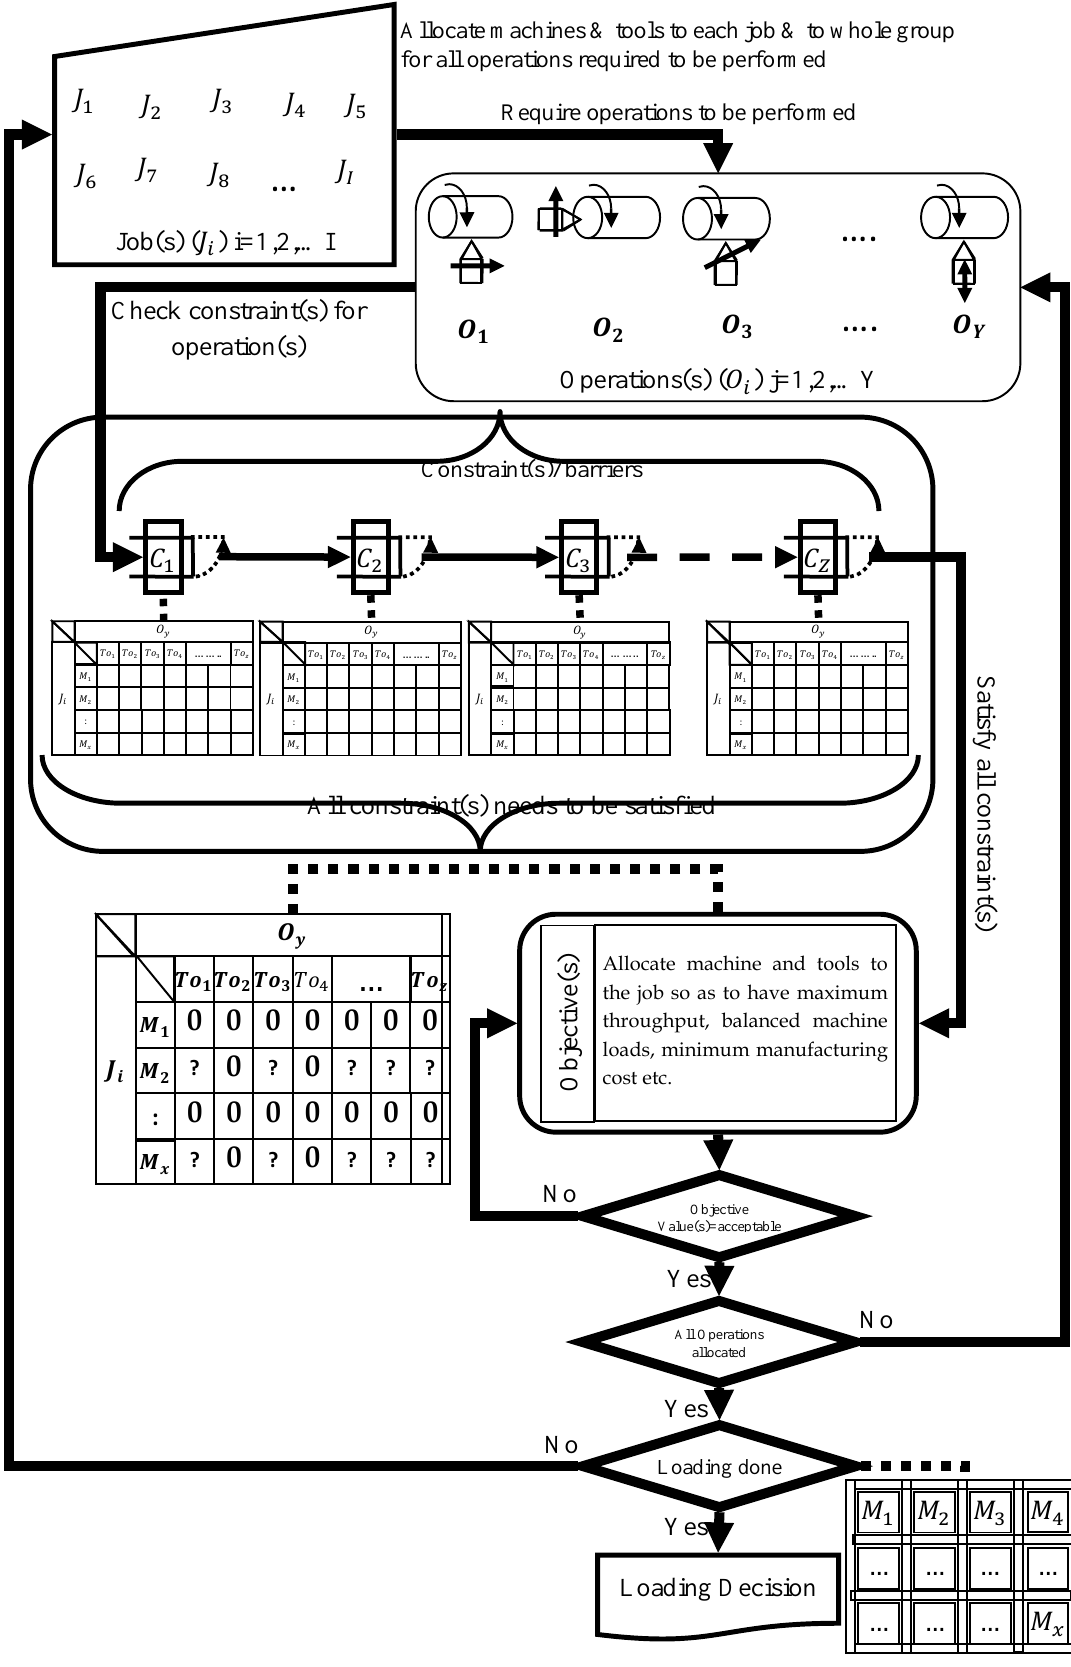
Fig. 1. Diagrammatic representation of the loading